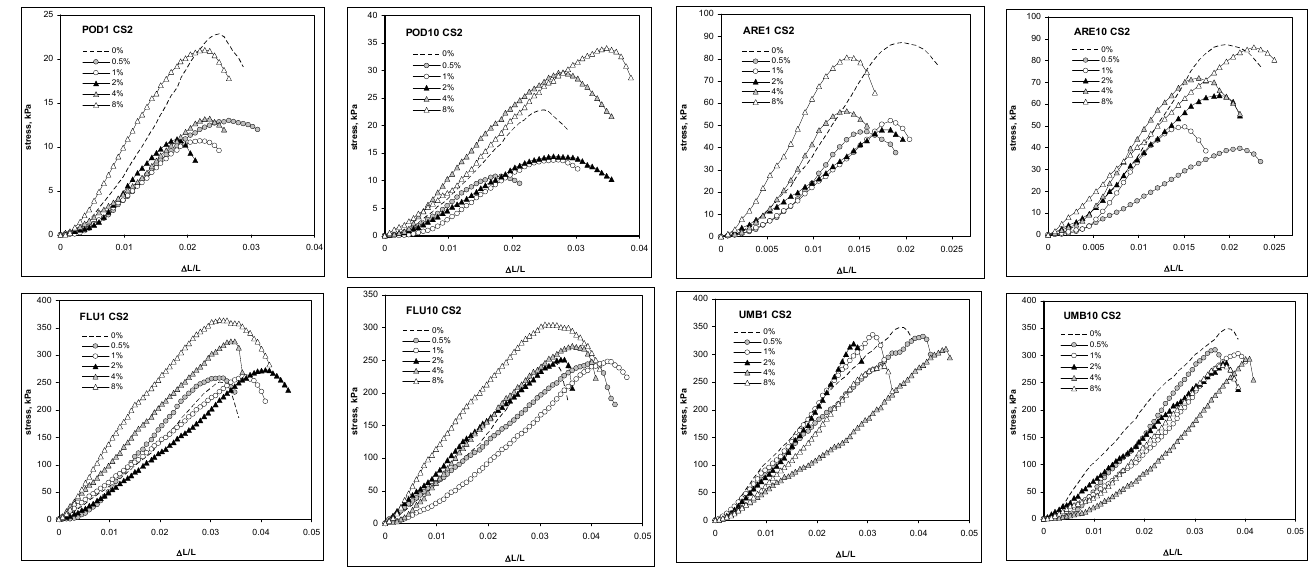
Figure 2. Exemplary compression stress-dilatation dependence for the aggregates of Podzol (POD), Fluvisol (FLU), Umbrisol (UMB) and Arenosol (ARE) amended with different amounts of chitosan CS2, preconditioned with 1 or 10 cycles of wetting–drying. The number of the cycles is written after the abbreviation of each soil.